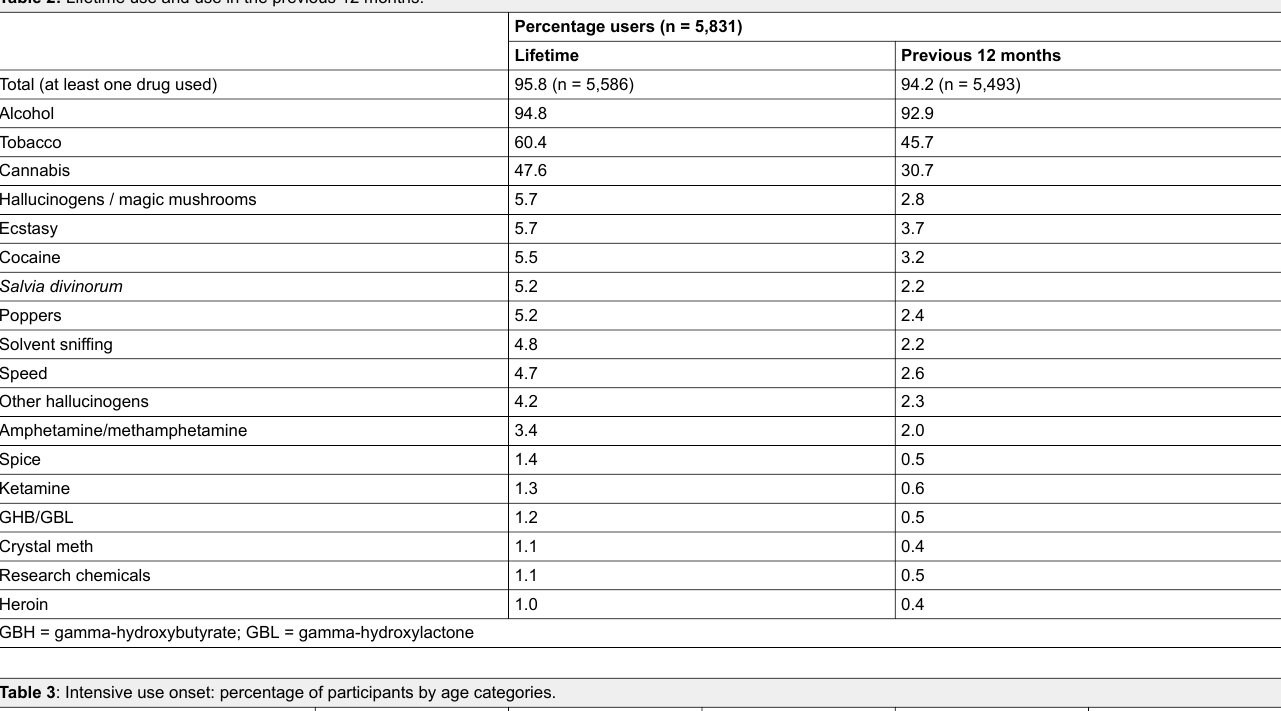
Table 2: Lifetime use and use in the previous 12 months.